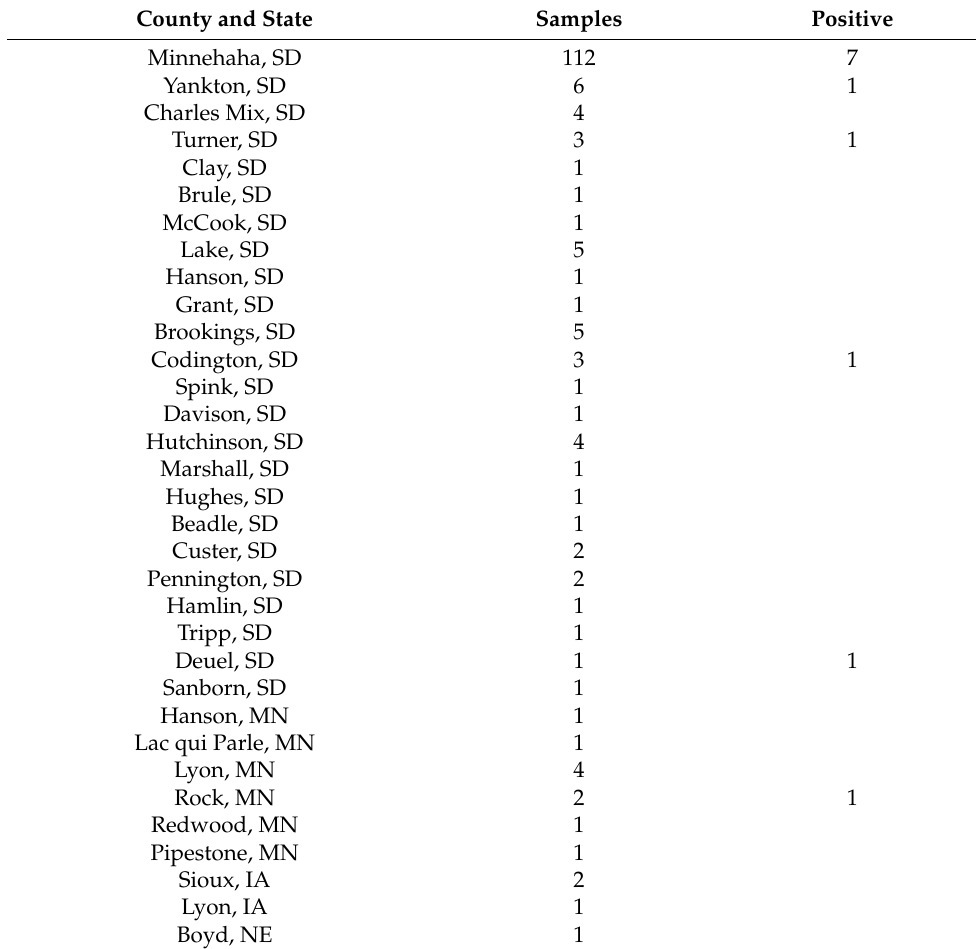
Table 1. Distribution of bat samples tested and pan-coronavirus positive